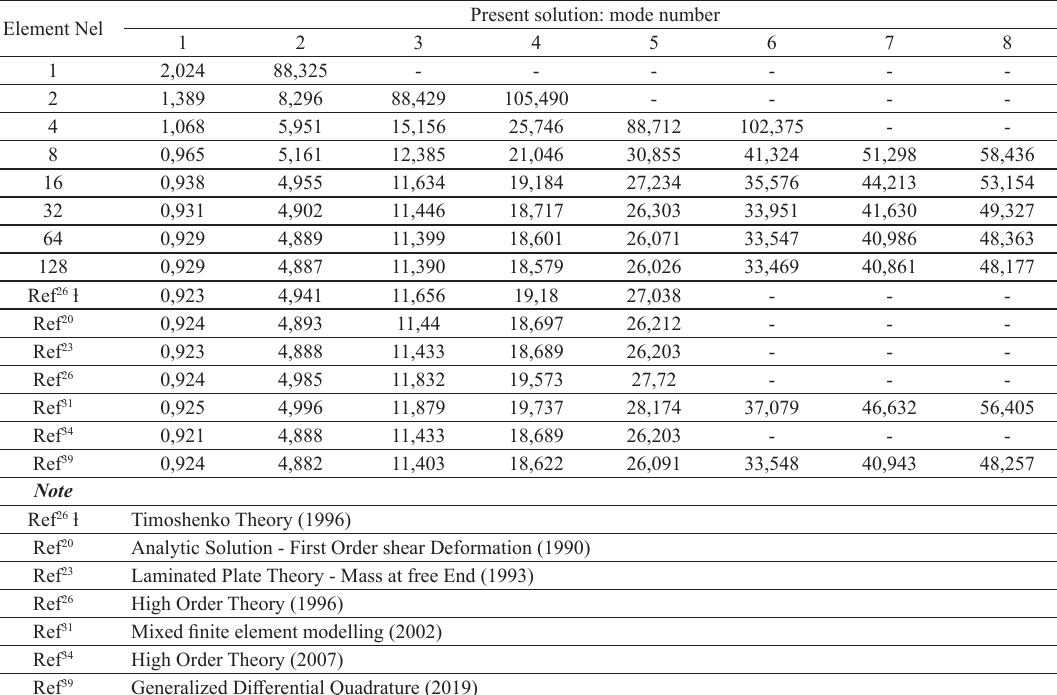
Table 4. Natural frequencies (nondimensional values) for CF beam Laminated composite with (0/90/90/0) lamination scheme. Model containing parasitic shear. Element